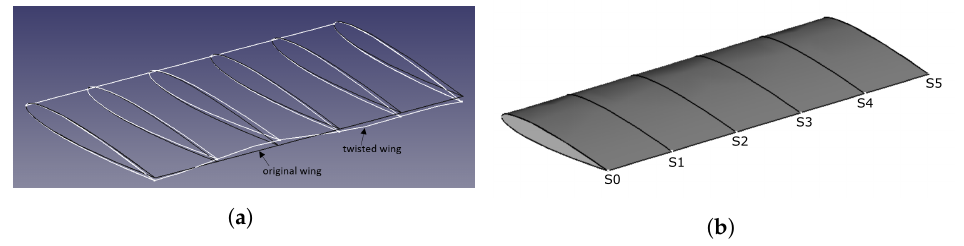
Figure 4. Wing design: ( a ) original and twisted wing profiles; ( b ) CAD model.